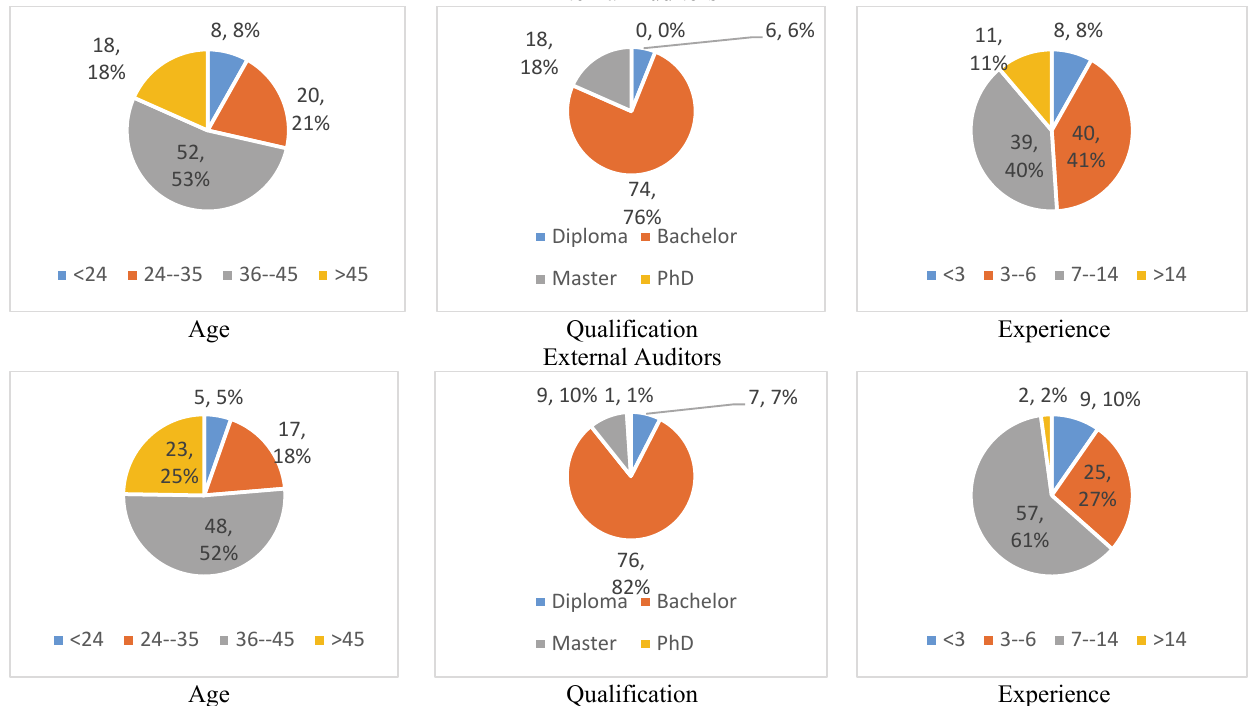
Fig. 1. Description of the study